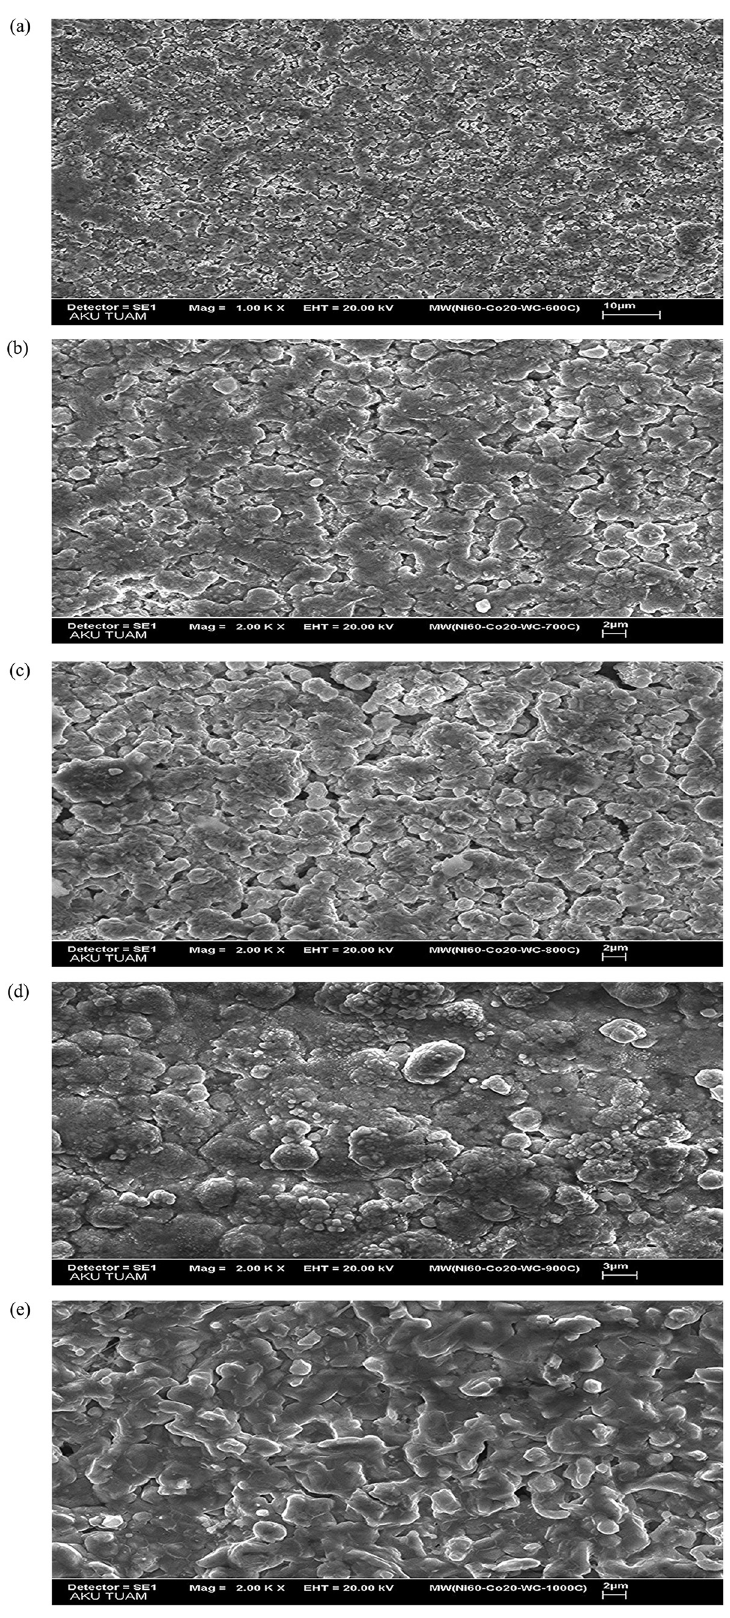
Figure 3: SEM image of ( Ni – Co – WC ) composite 600 – 1,000°C. ( a ) 600°C, ( b ) 700°C, ( c ) 800°C, ( d ) 900°C and ( e )